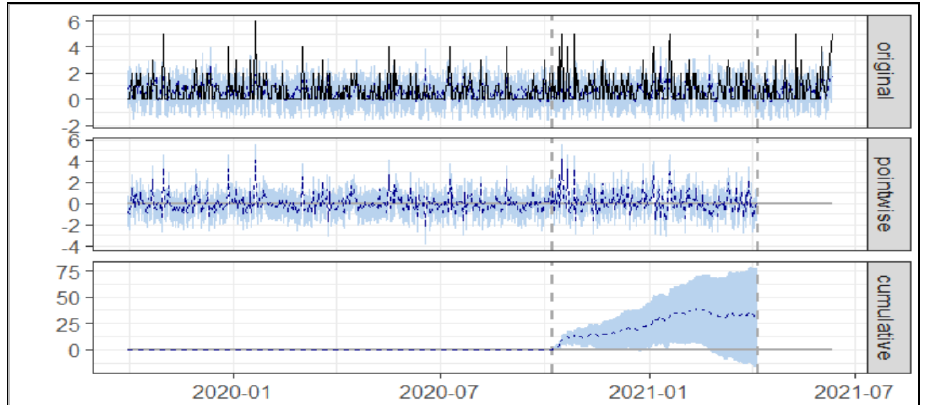
Figure 3. The trend of prescription of Asacol ® prior to and during the implementation of intervention 1. Note: The first panel shows the data and a counterfactual prediction for the post-treatment